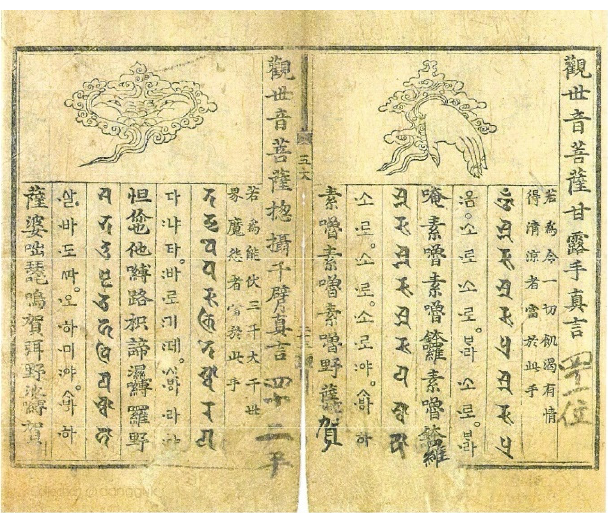
Figure 1. Trilingual layout from “The Forty-two Hand-Mantras” section of Five Great Mantras . ( Odae chin ŏ n n.d. A, p. 24).